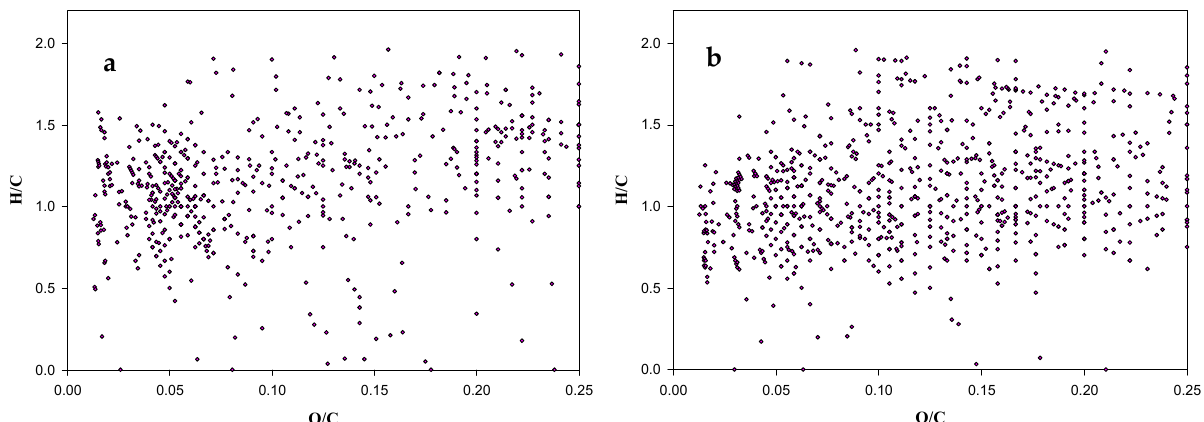
Figure 14. The van Krevelen plots of the O 1 -O 10 species found in the not-treated WSF of crude oil ( a ) and after 1-h of sonophotocatalytic treatment ( b ).